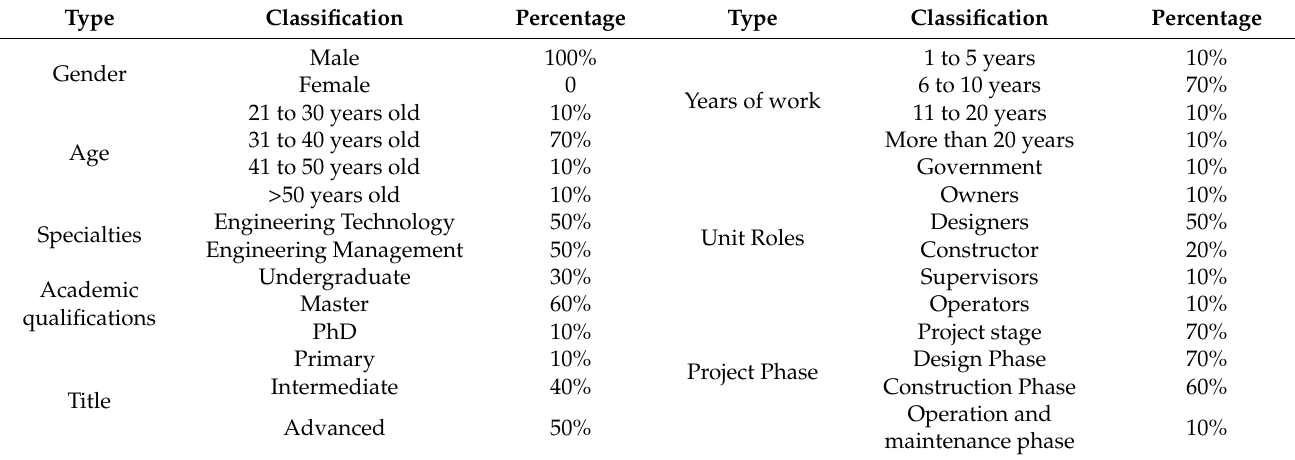
Table 1. Background information of interviewed